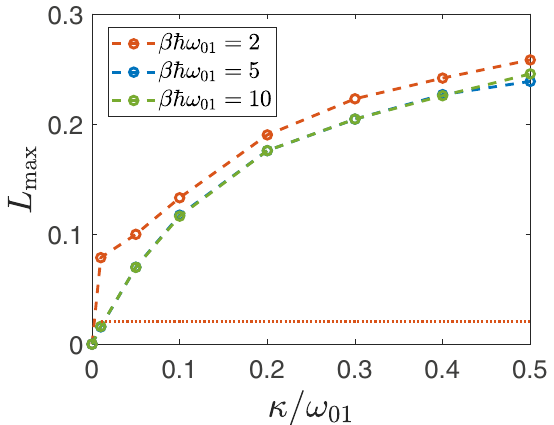
Fig. 3 Maximum state leakage for different coupling strengths and temperatures. Maximum state leakage for the decay from the fi rst excited state calculated with SLED. Note that blue and green lines almost overlap each other. Dotted lines indicate the steady- state thermal leakage calculated using the Boltzmann distribution for β ℏ ω 01 = 2. Here E J / E C = 100, ω c = 50 ω 01 , and N = 5.